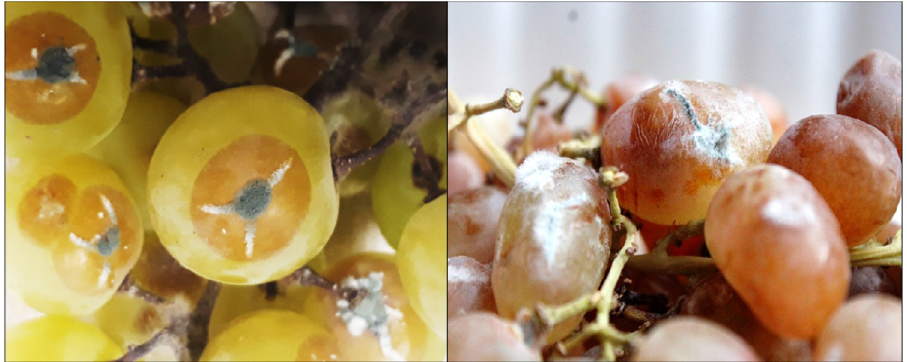
Figure 1: Symptomology of blue mold disease associated with Penicillium